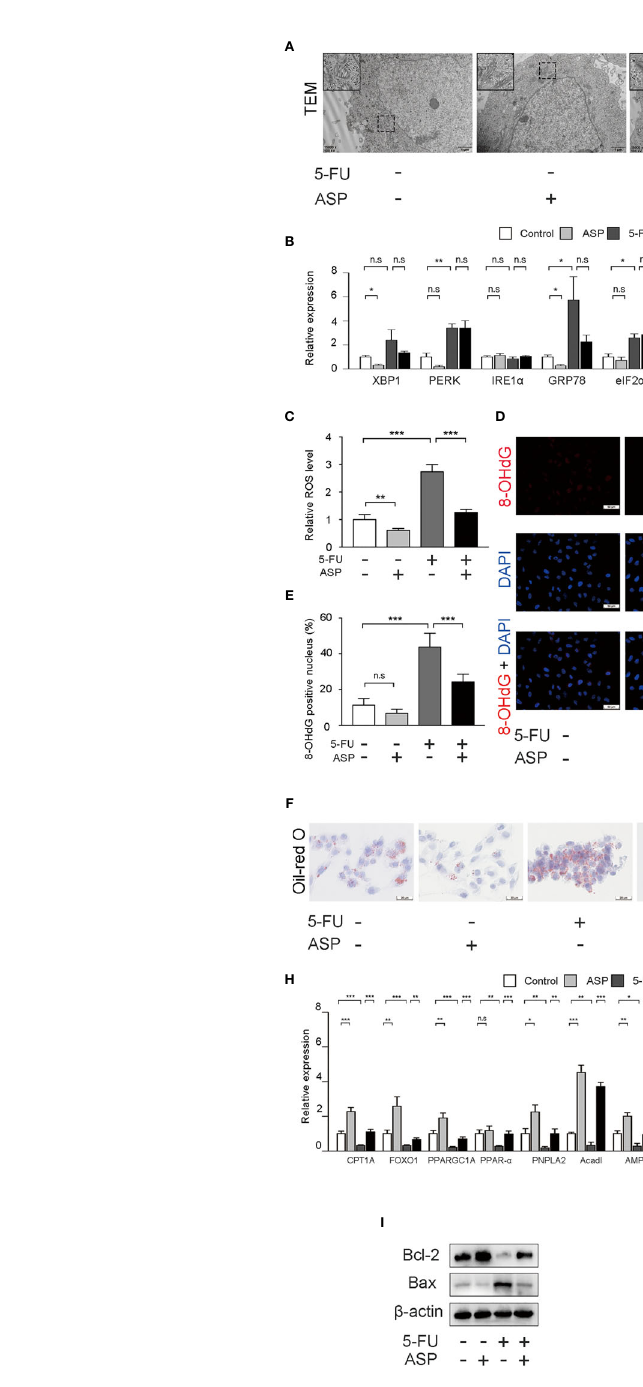
FIGURE 6 | ASP treatment reduced 5-FU-induced cell oxidative damage and apoptosis and inhibited lipid metabolism gene expression in vitro. (A) Cell ultrastructure was observed under a TEM (magni fi cation, × 15000, scale bar, 1 m m). The solid arrow points to the lipid droplet, and the open arrow points to the swollen endoplasmic reticulum. The swollen mitochondria are shown within the box at a higher magni fi cation. (B) The expression of 9 genes related to endoplasmic reticulum stress was detected by RT-qPCR. b -actin was probed as an internal control ( n = 3). (C) ROS production of the indicated groups ( n = 6/group). (D, E) Representative immuno fl uorescence images and the quanti fi cation of 8-OHdG staining in cells (magni fi cation, × 400, scale bar, 20 m m). (F) Oil Red O staining of cells (magni fi cation, × 400, scale bar, 20 m m). (G) Oil Red O-positive areas were analyzed using ImageJ ( n = 6/group). (H) The expression of lipid synthesis and metabolism-related genes in cells was detected by RT-qPCR assay ( n = 3). b -actin was probed as an internal control. (I) Western blot assay was performed to determine the expression levels of Bax and Bcl-2. (J) The intensity of the bands was calculated using ImageJ software ( n = 3/group). * p < 0.05; ** p < 0.01; *** p < 0.001. n.s., not statistically signi fi